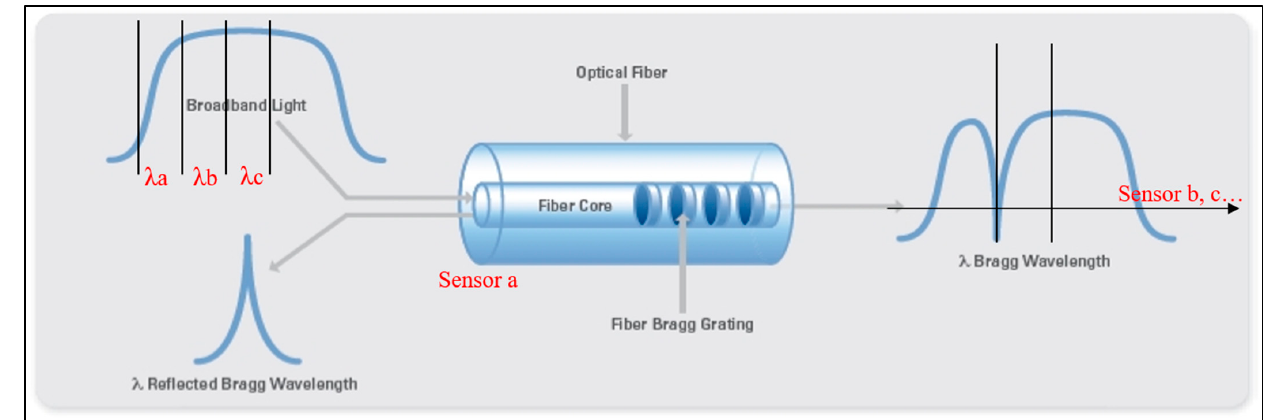
Figure 1. Spectral response for a definite grating period and shifting of Bragg wavelength λ of an FBG subjected to axial loading and temperature. Each of a series of FBG sensors (e.g., sensor a, b, c, …) can occupy a certain broadband light (e.g., λ a, λ b, λ c, …). λ : Bragg wavelength shift.